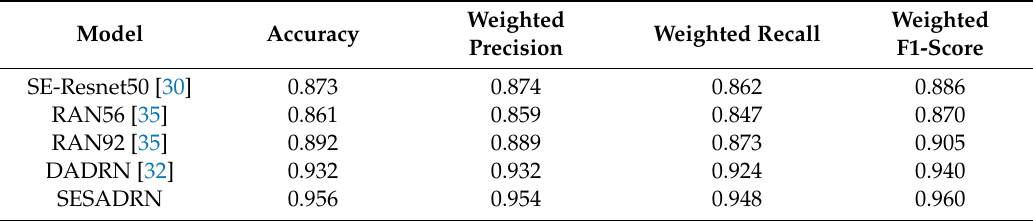
Table 2. Comparison of 30-class classification performance.